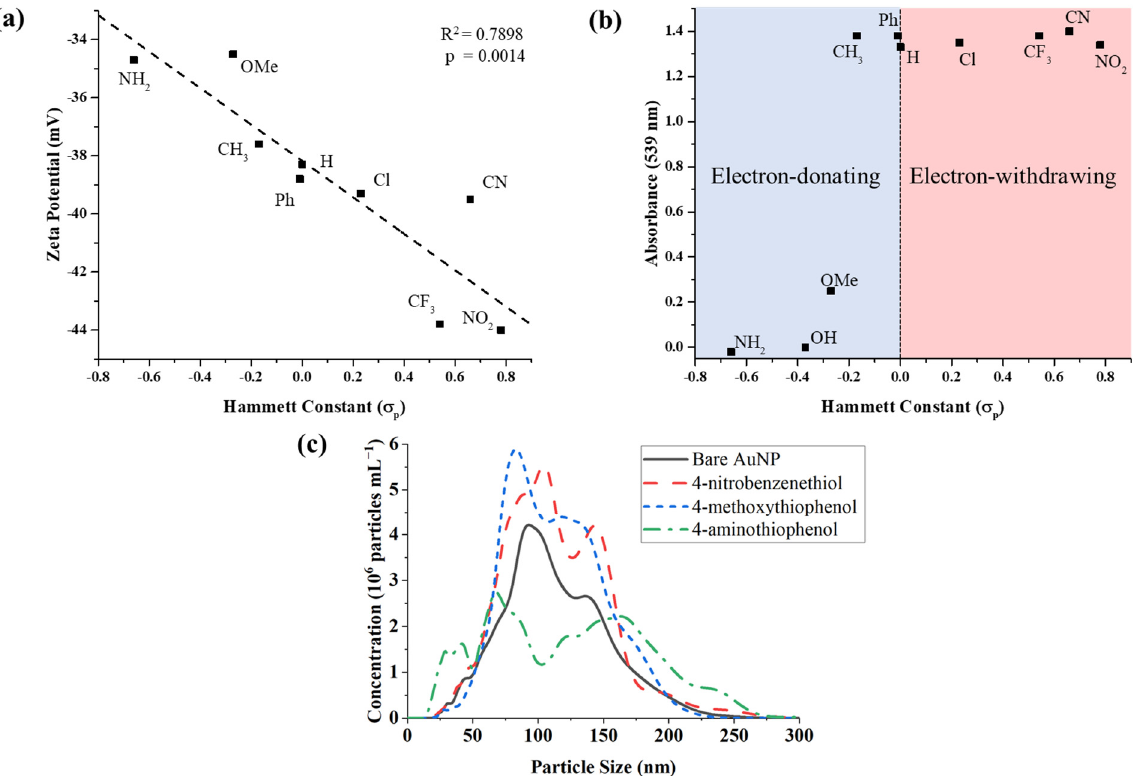
Figure 2. Measured effects of thiophenol functional group modifications on gold nanoparticles. ( a ) Zeta-potential measurements of AuNPs treated with para-substituted thiophenols. Hammett constants ( σ p ) of the varied substituent are negatively correlated with AuNP surface charge (R 2 = 0.79, p = 0.0014). ( b ) UV-visible absorbance data show the impact of thiophenol inductive effects on AuNP precipitation. P-thiophenols with σ p ≥ − 0.25 did not cause aggregation, while those with σ p < − 0.25 did. ( c ) Size distributions of thiol-coated AuNPs obtained via nanoparticle tracking analysis (NTA).